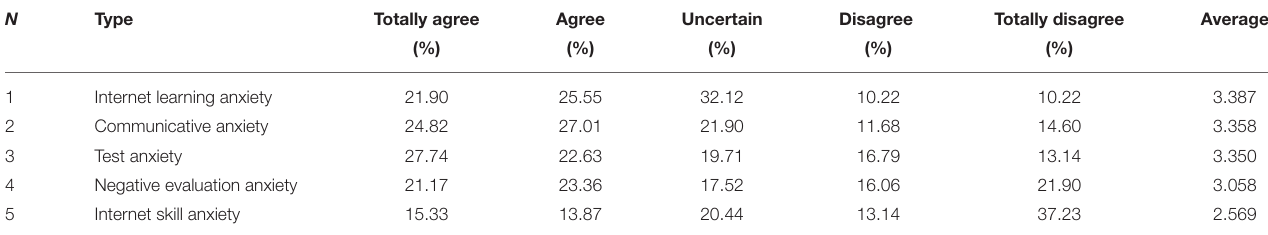
TABLE 1 | Distribution data of different anxiety types.